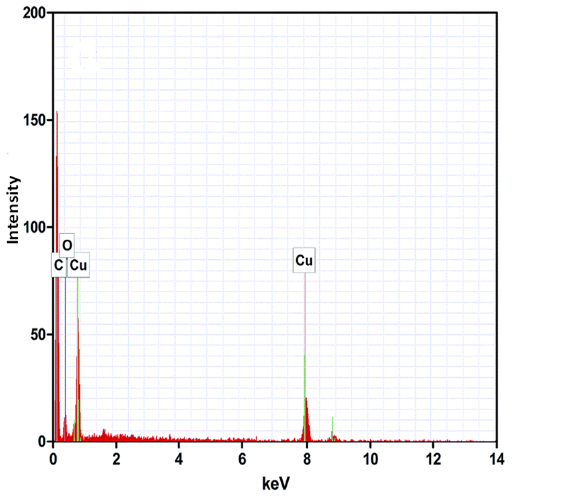
Figure 4. Cyclic voltammograms of the electrodeposition of CuNPs. Experimental conditions: 0.1 M Na 2 SO 4 , 10 − 3 M CuSO 4.